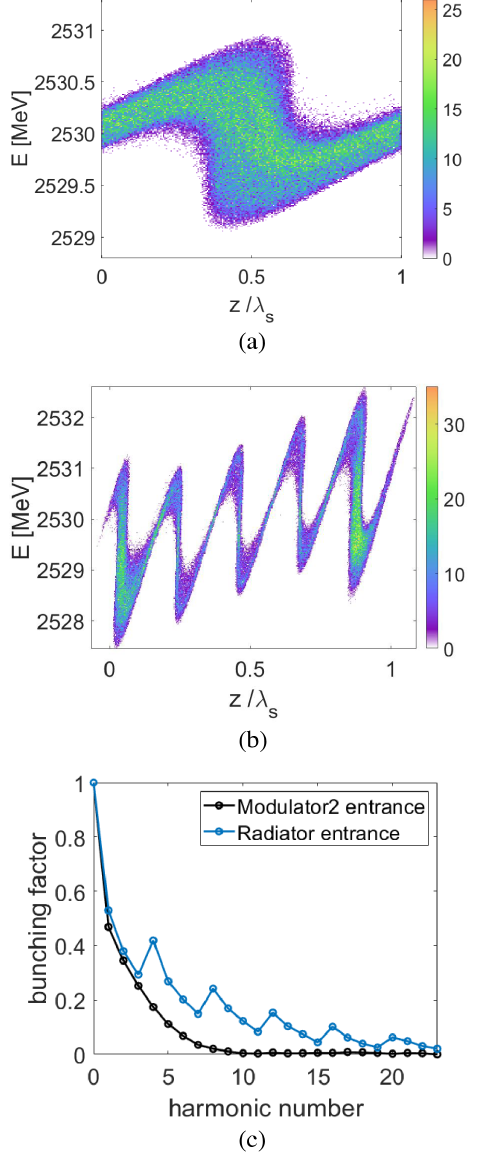
FIG. 3. (a) Longitudinal phase space of the electron bunch at the entrance of modulator 2 and (b) at the entrance of the radiator. (c) Bunching factor for different harmonics at the entrance of modulator 2 and at the entrance of the radiator ( R 56 ; 1 ¼ 30 μ m, R ¼ 4 μ 56 ; 2